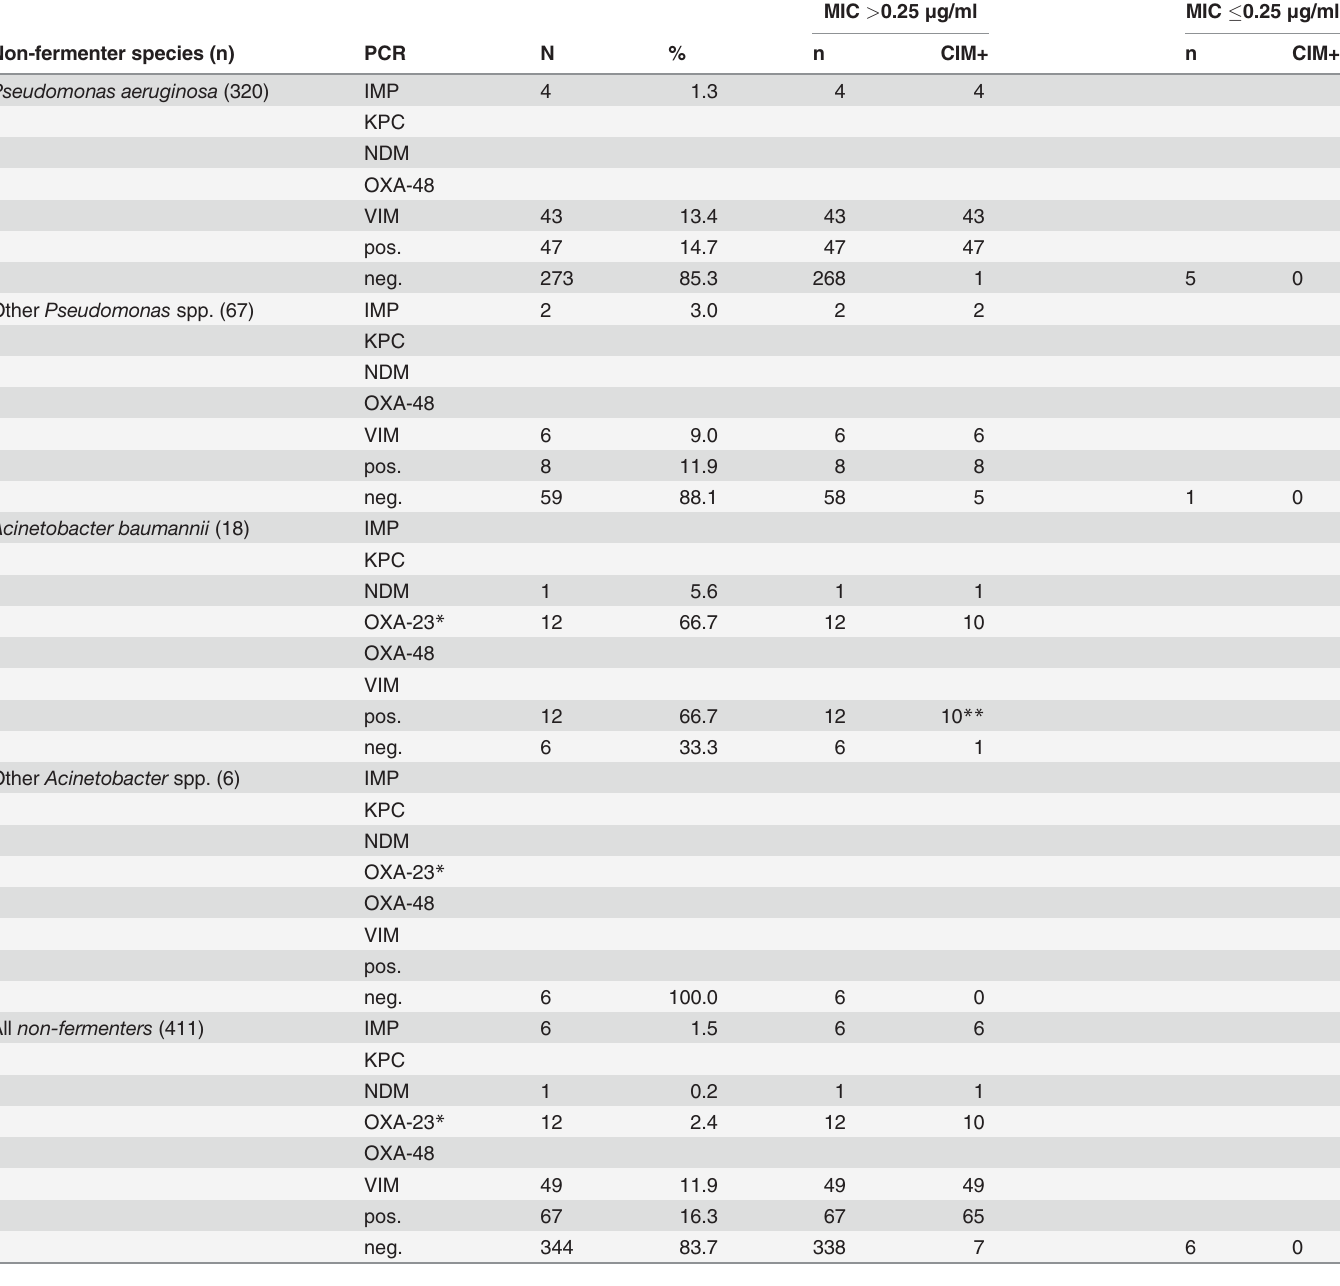
Table 3. Characteristics of non-fermenter isolates submitted for CPE during the first halves of 2012 and 2013.